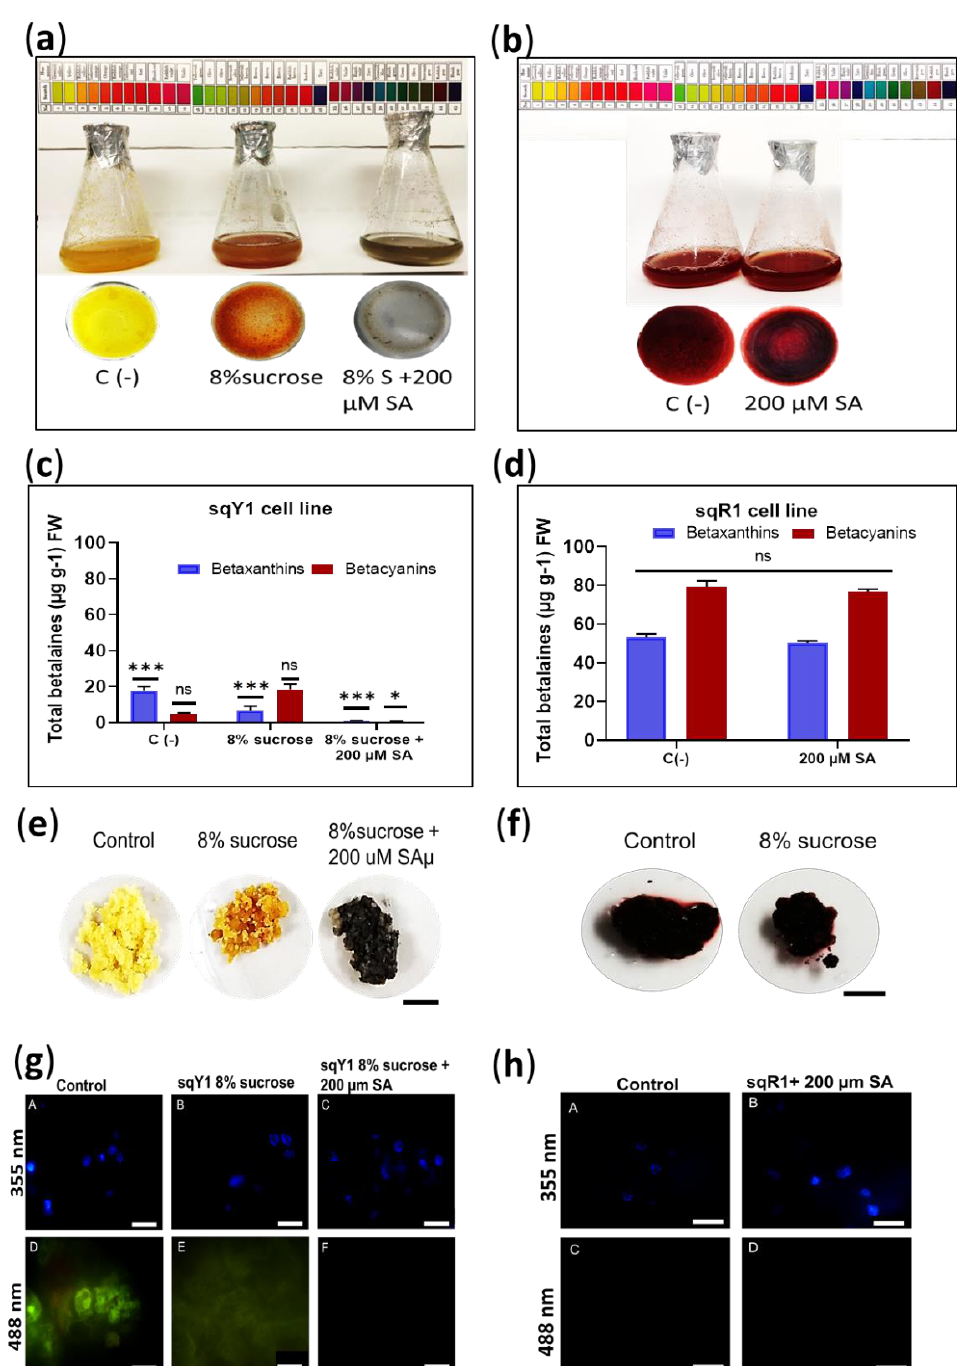
Figure 3. Effect of exogenous application of SA and variation of sucrose source in sqY1 and sqR1 lines. ( a ). Effect of exogenous SA application on sqY1 and ( b ) sqR1 cell lines. ( c ) Quantification of total betaxanthins and ( d ) total betacyanins in sqY1 line in response to exogenous SA application. ( e ) Cell cluster formation in the sqY1 line and ( f ) in the sqR1 line. Bar scale 1 cm. ( g ) Epifluorescence microscopy of the subcellular structure under the study conditions in the sqY1 line ( h ) and the sqR1 line. Bar scale 10 µ m. All experiments were obtained at a significance level with three independents replicates. (*) Indicate statistical significance at p < 0.05, (***) Indicate statistical significance at p < 0.001. (ns) Indicate no statistical significance, as described in materials and methods. 2.4. Exposure of Different NaCl Concentration to S. queretaroensis Cell Lines The effect of salt stress induced by the addition of 100 mM was determined in the sqY1 and sqR1 cell lines. This treatment induced a change in cell pigmentation (from yel-